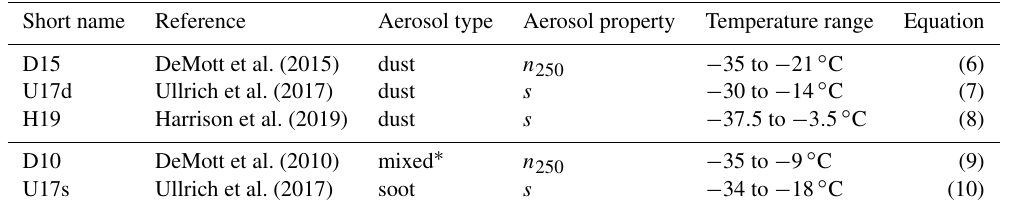
Table 1. Overview of INP parameterizations for immersion freezing mode considered in this study along with the aerosol type they are applicable to, the aerosol property they are based on ( n 250 : aerosol number concentration of particles with radii ≥ 250nm; s : aerosol surface area concentration), the applicable temperature range, and the explicit form equation number in this paper. This overview was adapted from the more extensive summary given by Marinou et al. (2019, Table